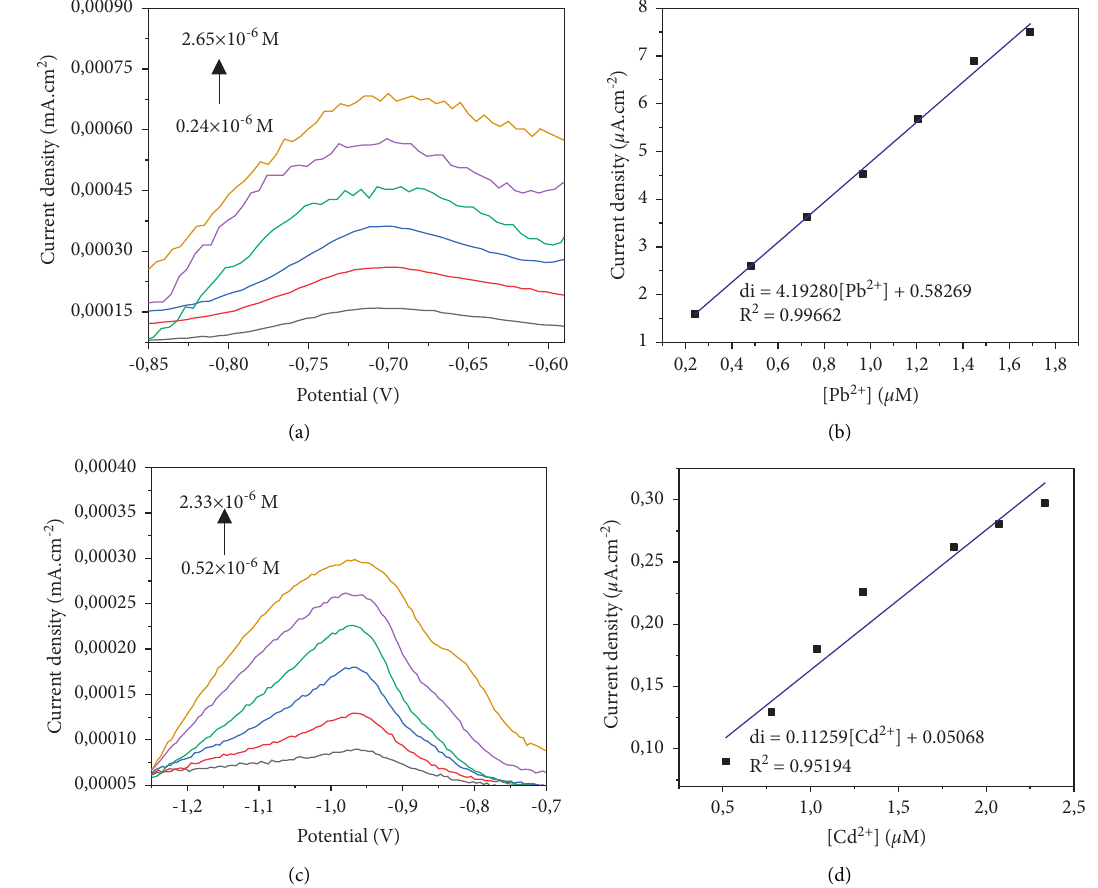
Figure 11: Effect of the concentration and calibration curve of the Pb 2+ ions (a, b) and Cd 2+ (c, d).